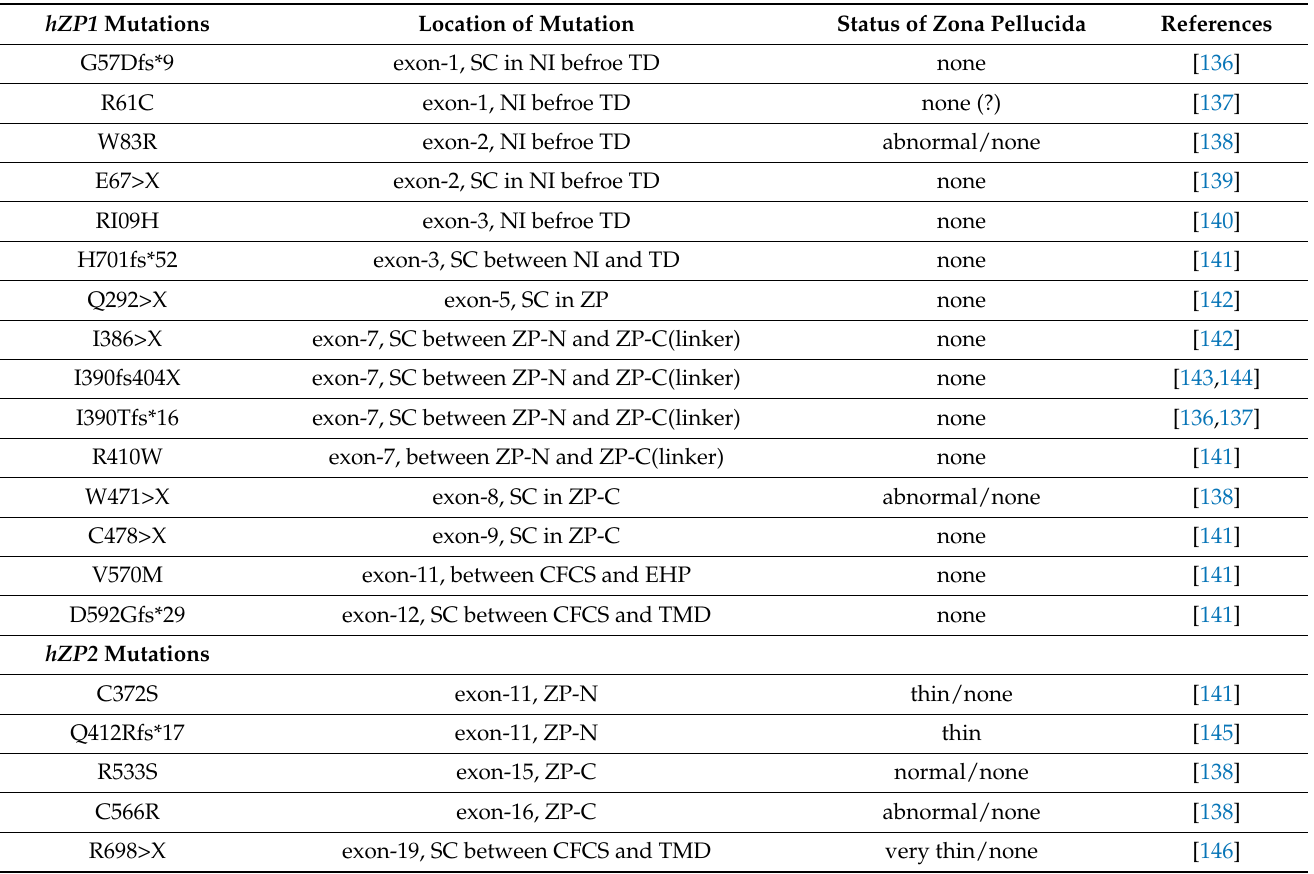
Table 4. hZP1–4 Mutations in Infertile Human